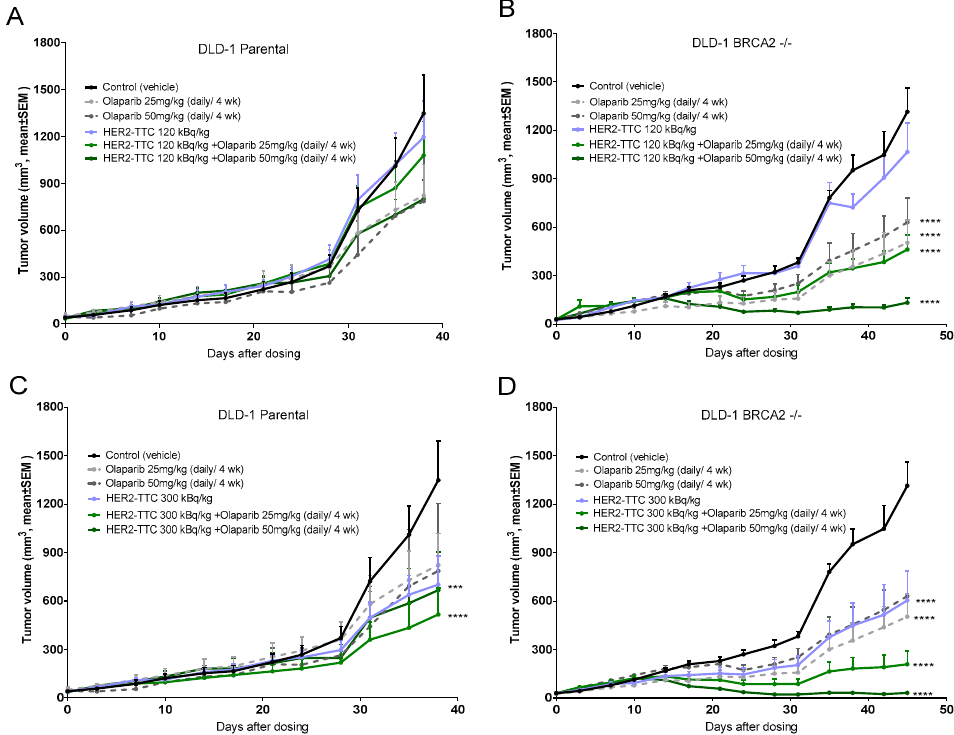
Figure 5. In vivo e ffi cacy of combination treatment with HER2-TTC and olaparib in DLD-1 parental xenograft and DLD-1 BRCA2 - / - xenograft. ( A ) Tumor size determined in DLD-1 parental after a single dose administration of HER2-TTC (120 kBq / kg bw, 0.14 mg / kg bw, i.v.) and olaparib (25 or 50 mg / kg bw daily for four weeks) as monotherapies or in combination treatment as compared to vehicle, ( B ) tumor size determined in DLD-1 BRCA2 - / -, after a single dose administration of HER2-TTC (120 kBq / kg bw, 0.14 mg / kg bw, i.v.) and olaparib (25 or 50 mg / kg bw daily for four weeks) as monotherapies or in combination treatment as compared to vehicle, ( C ) tumor size determined in DLD-1 parental after a single dose administration of HER2-TTC (300 kBq / kg bw, 0.14 mg / kg bw, i.v.) and olaparib (25 or 50 mg / kg bw daily for four weeks) as monotherapies or in combination treatment as compared to vehicle, and ( D ) tumor size determined in DLD-1 BRCA2 - / -, determined after a single dose administration of HER2-TTC (300 kBq / kg bw, 0.14 mg / kg bw, i.v.) and olaparib (25 or 50 mg / kg bw daily for four weeks) as monotherapies or in combination treatment as compared to